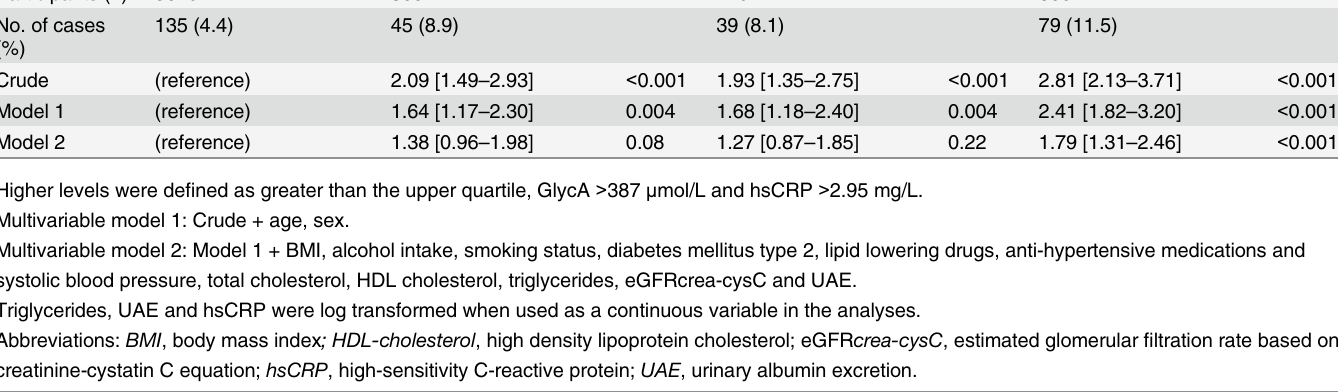
Table 4. Associations of joint GlycA and hsCRP levels and cardiovascular events in 4,759 participants (298 events) of the PREVEND study. Low GlycA and low